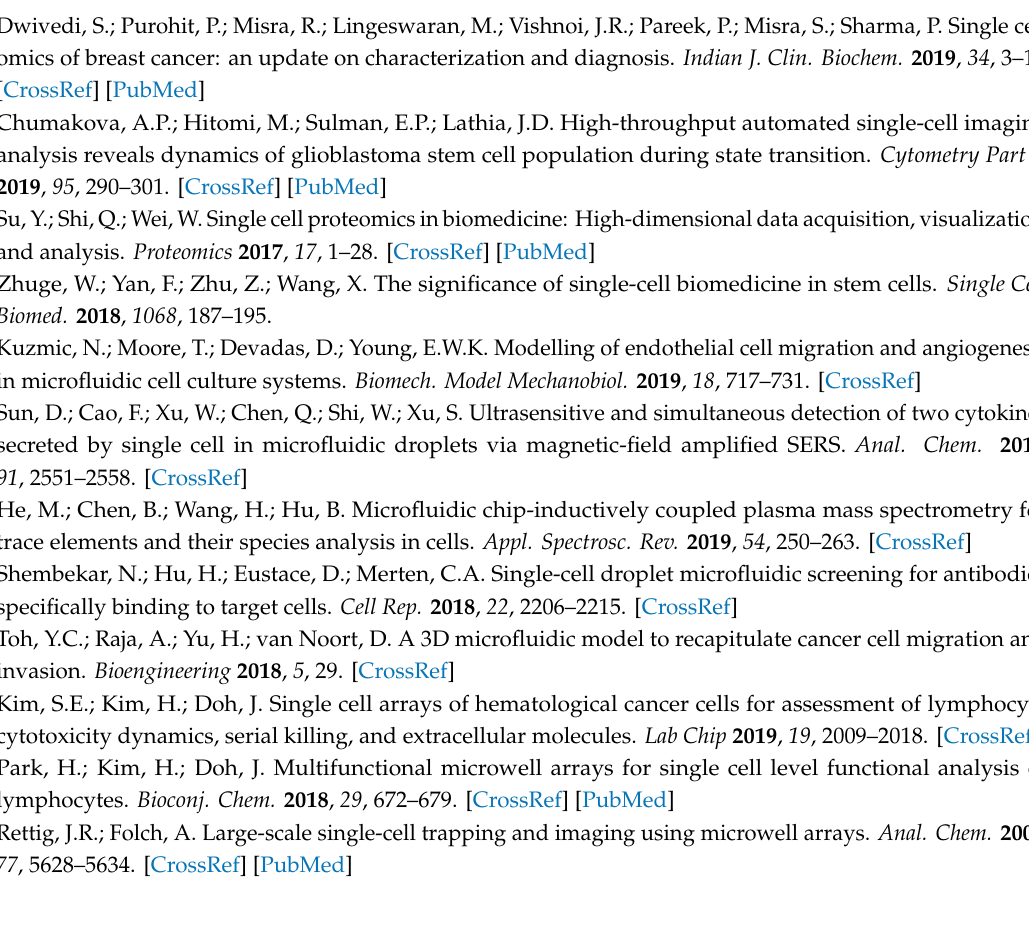
Figure S1: schematic of digital micromirrors, Figure S2: relation between deepness of the microwells and exposure time, and Figure S3: SEM image of microwell